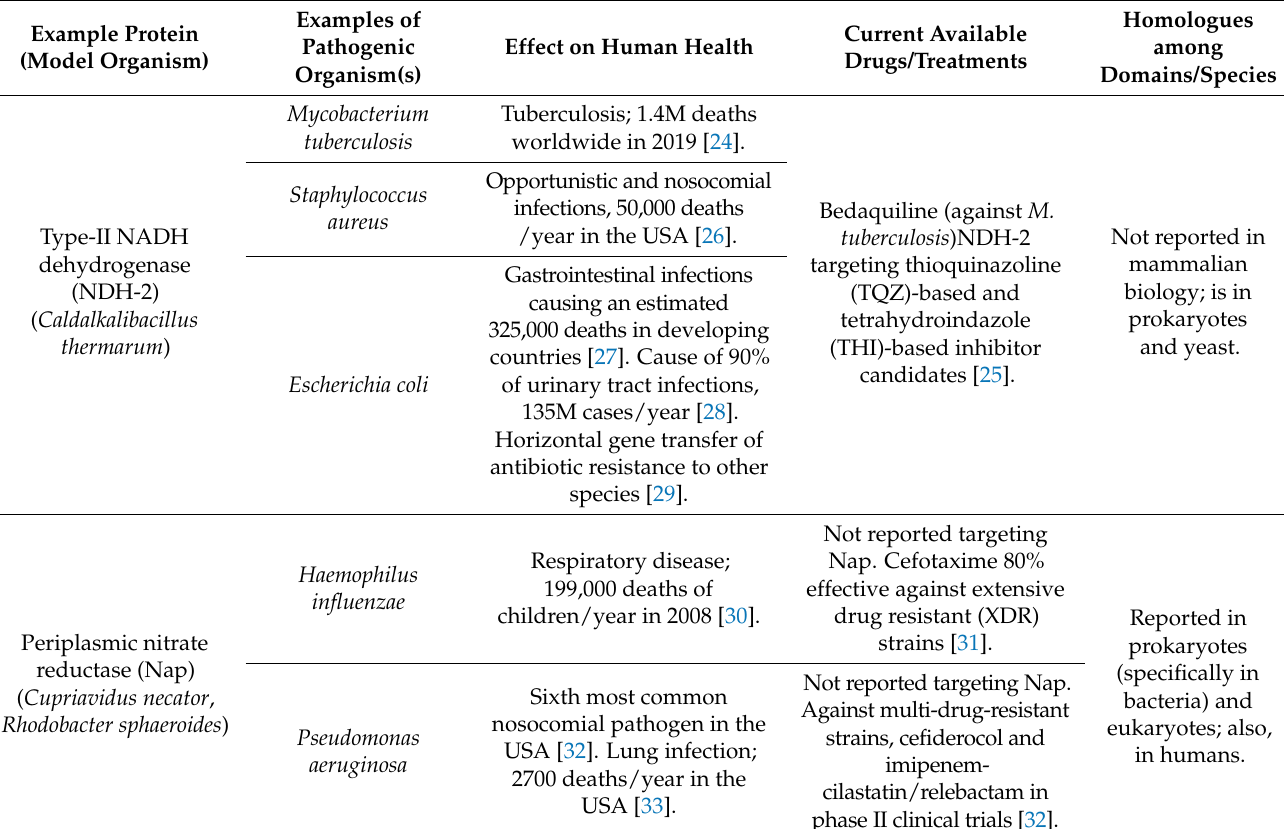
Table 1. Examples of PMPs as key drug targets. The examples of pathogenic organisms in which the protein exists, the effect of the corresponding disease on human health, the currently available drug targets, and the homologues among different domains are described for type-II NADH dehydrogenase [24–29], periplasmic nitrate reductase [30–33], CymA, alkaline phosphatase [34,35], ecto-5 (cid:48) -nucleotidase [36,37], acetylcholine esterase [38,39], alternative oxidase [40,41], cytochrome c [42,43], and dihydroorotate dehydrogenase